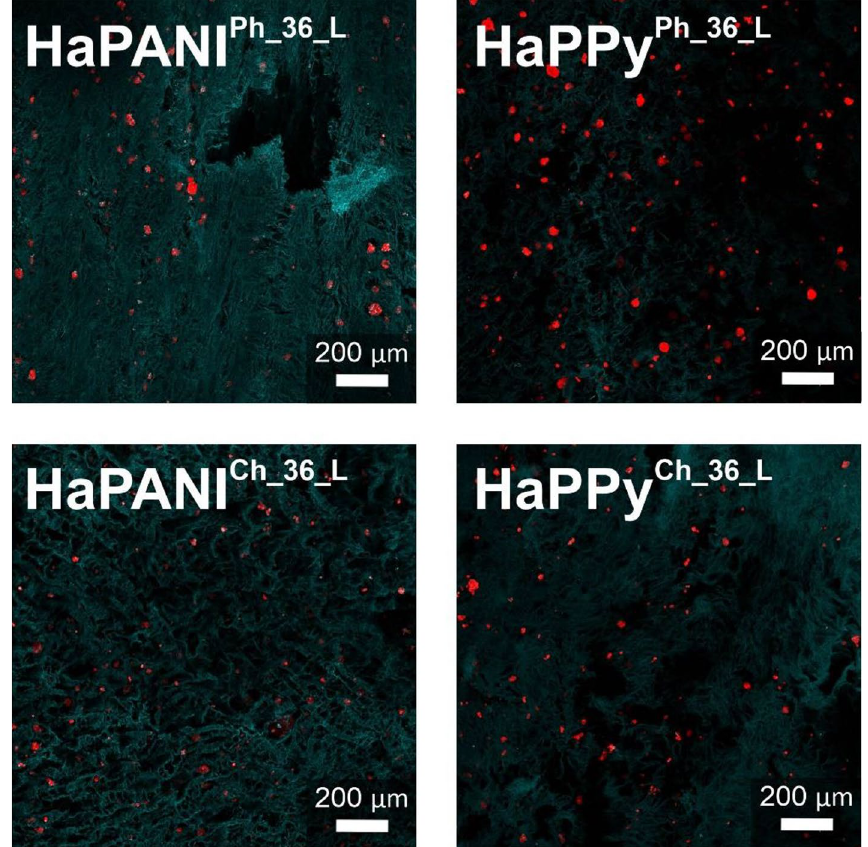
Figure 10. Cell ingrowth into the structure of scaffolds. Cell nuclei were counterstained with Hoechst (blue); the cytoskeleton was counterstained with actin red (red). The green colour represents the hydrogel structure. Cells were seeded onto the surface of scaffolds before cultivation in a bioreactor. The images were taken from the cross-sections of scaffolds, namely from the centre of sample and 0.5 cm below the surface. The images thus represent cells which grow into the structure of scaffolds from its surface.